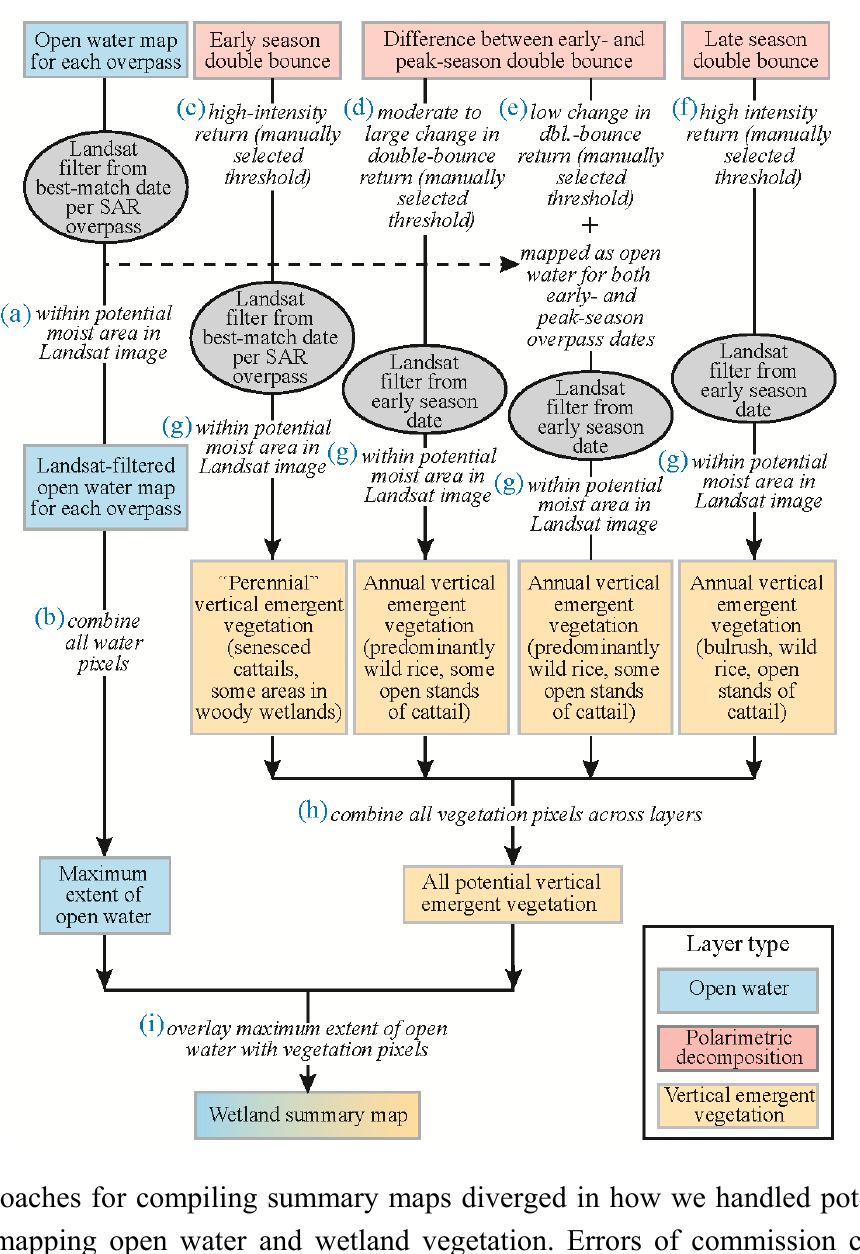
Figure 3. Processing steps to generate summary maps of wetlands for each year using data from SAR and Landsat